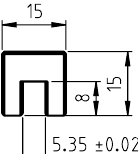
Figure 4. Geometry of the aluminum specimen holder (in mm). The nominal geometrical moments of inertia for the given geometry equate to I y = 4116.66 mm 4 , I z = 3343.02 mm 4 , and I t = 7459.68 mm 4 around the area’s